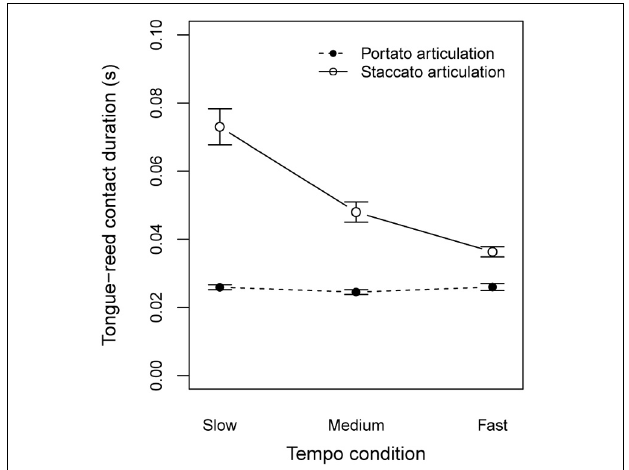
FIGURE 7 | Tongue-reed contact duration under different tempo conditions for portato articulation and staccato articulation. Error bars show the standard error of the